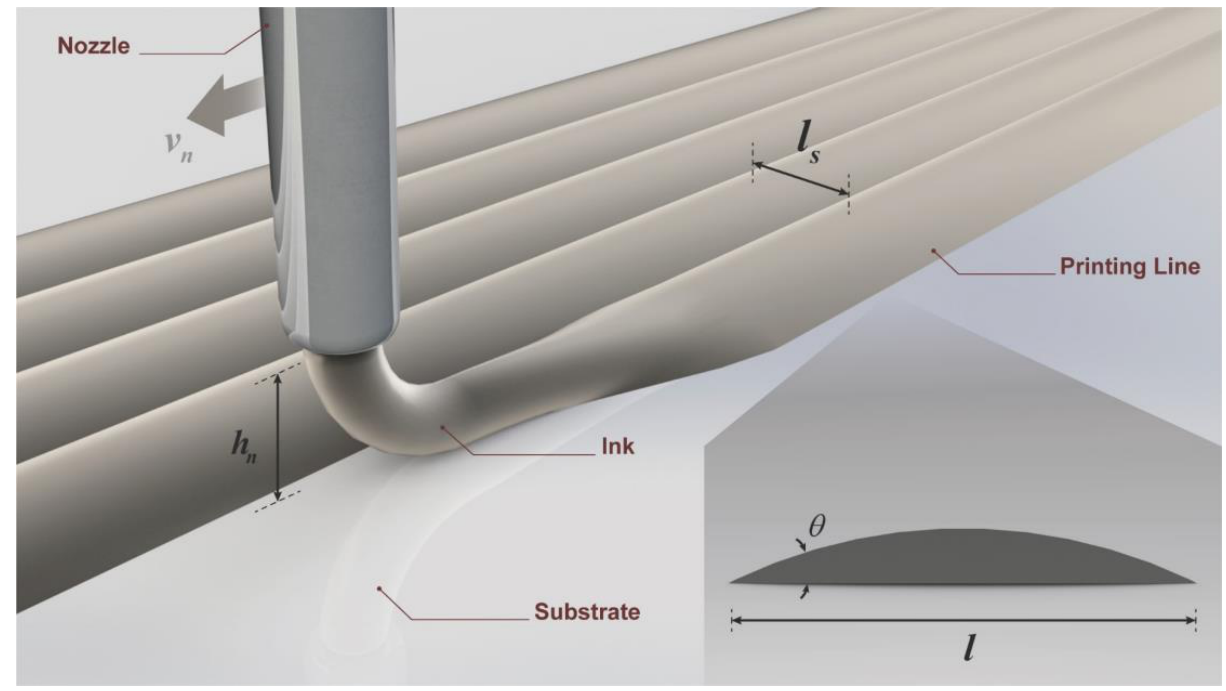
Figure 4. Schematic diagram of the process for printing an ink layer using DIW technology. During the printing process, the nozzle moves laterally at a velocity of v n at a height h n from the substrate, while the ink is extruded from the nozzle to print multiple ink lines in parallel with a spacing of l s . These ink lines merge through self-leveling, forming a flat surface. When printing a single ink line, a line with a width of l and a contact angle of θ is formed due to the self-leveling properties.